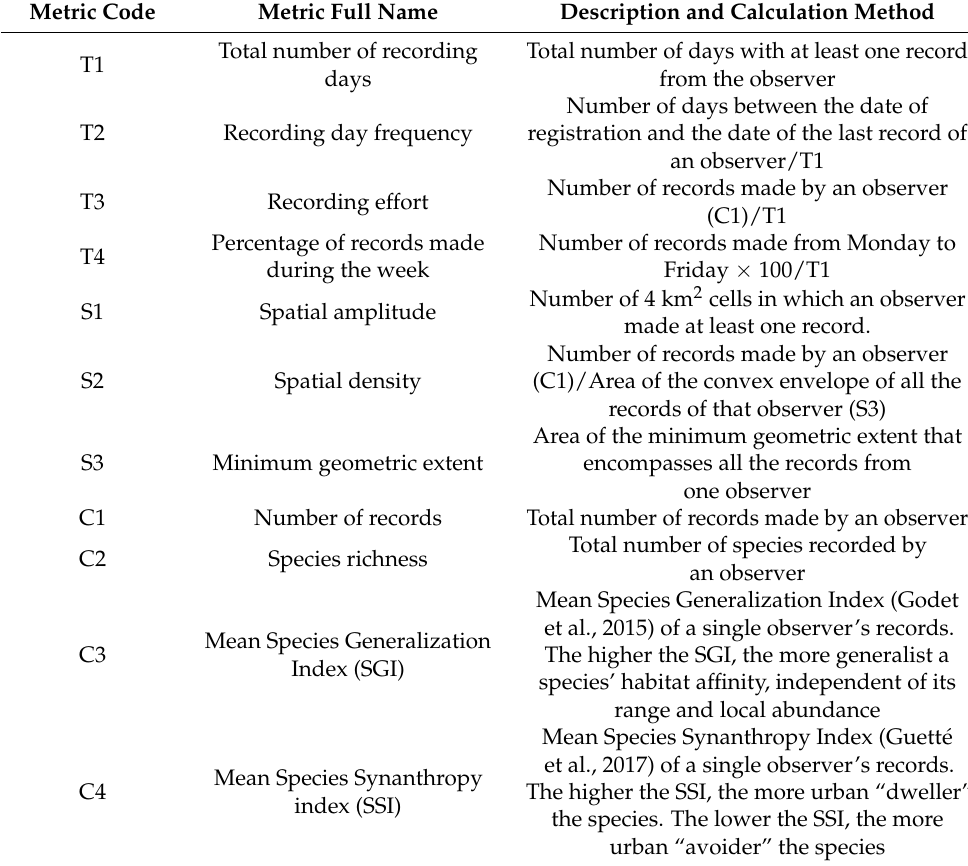
Table 1. The 11 metrics used to analyze observer profiles, in three categories (temporal habits (T), spatial habits (S), and record quality (C)), with their description and methods used for their